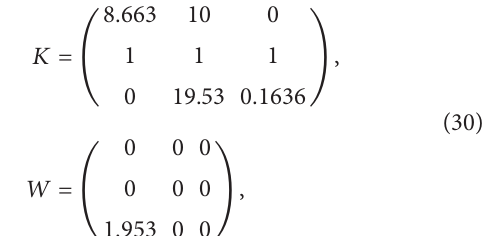
consisting of 12 identical Chua oscillators with time delayed nonlinearity is described by